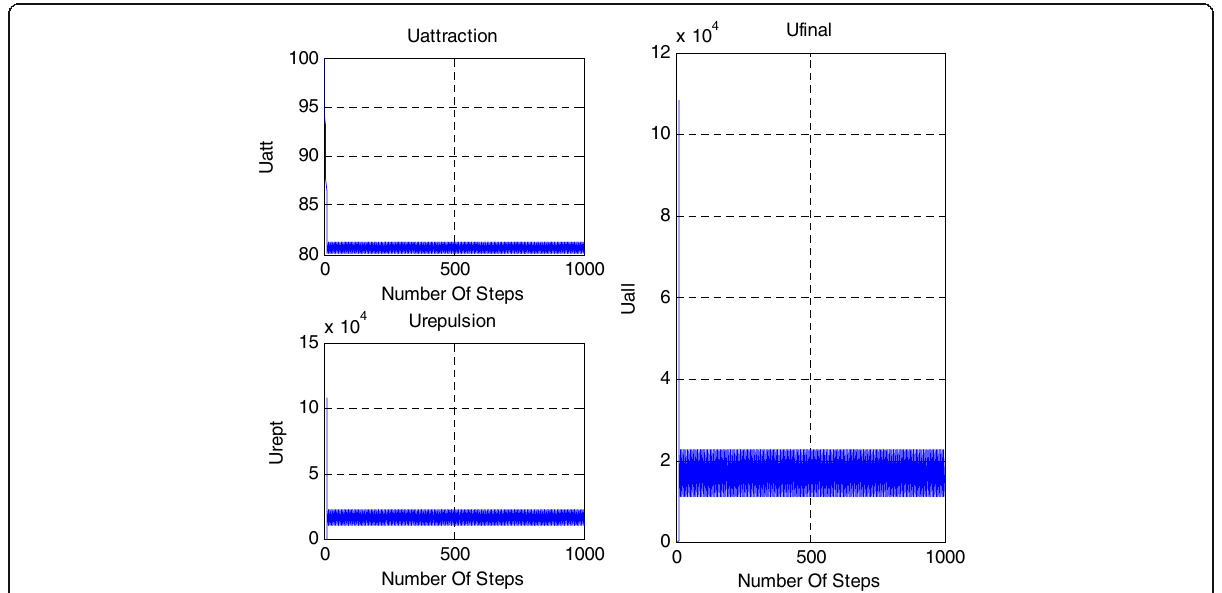
Fig. 9 The energy amount of repulsion and attraction and their yields according to the number of steps in the artificial potential field algorithm for circular obstacles with radius R = 0.18